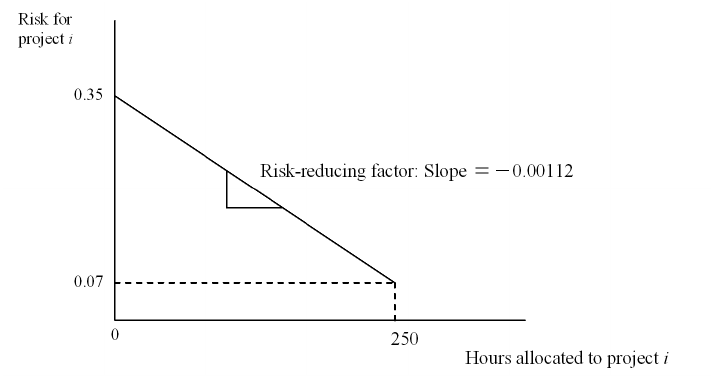
Figure 3: Determination of risk-reducing factor for project i